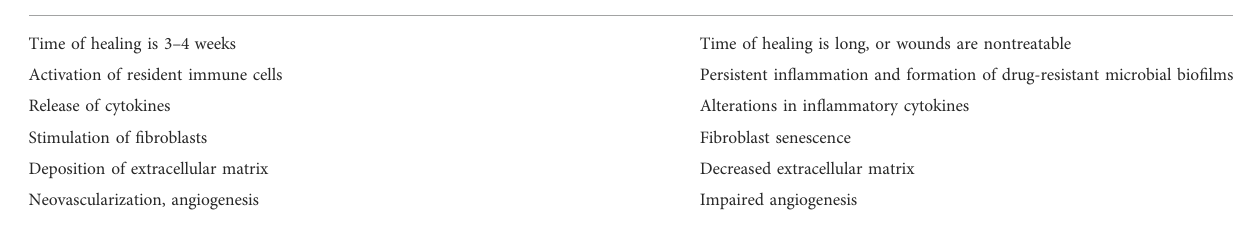
TABLE 1 Major differences between acute and chronic